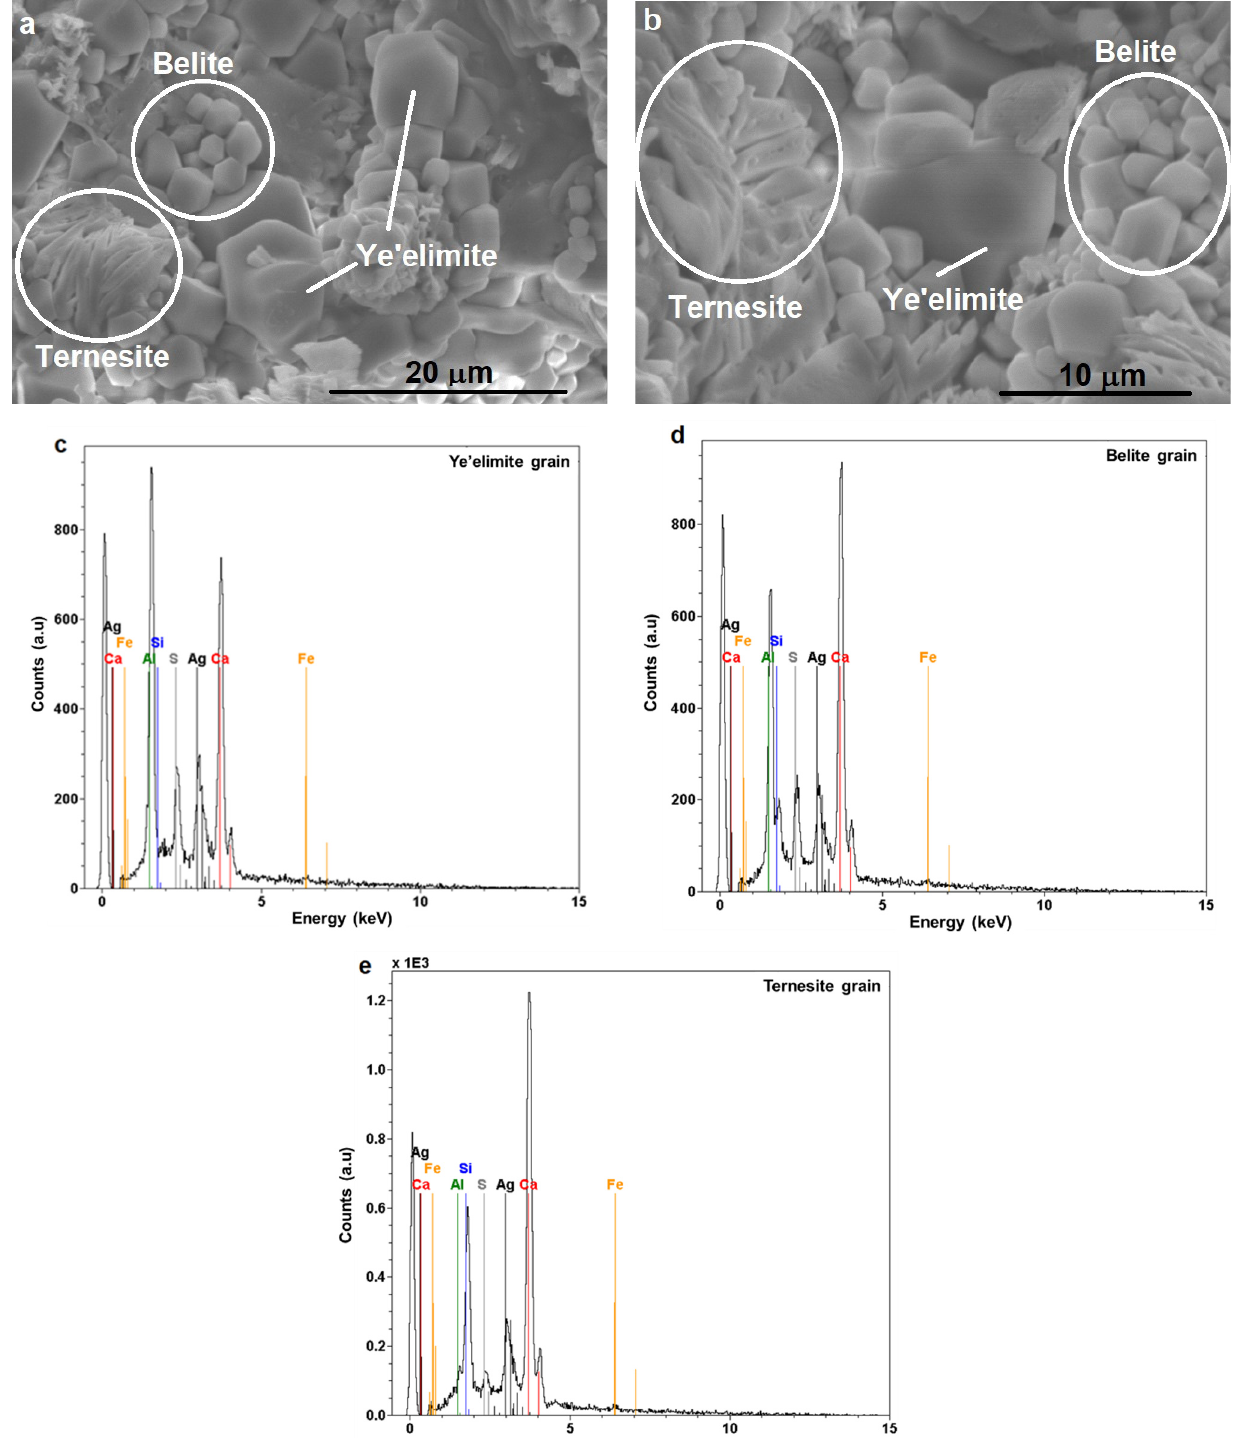
Figure 3. Scanning electron microscopy images ( a —x2.5k, b —x4k) associated with EDX analyses ( c – e ) on sintered clinker at 1300 °C.